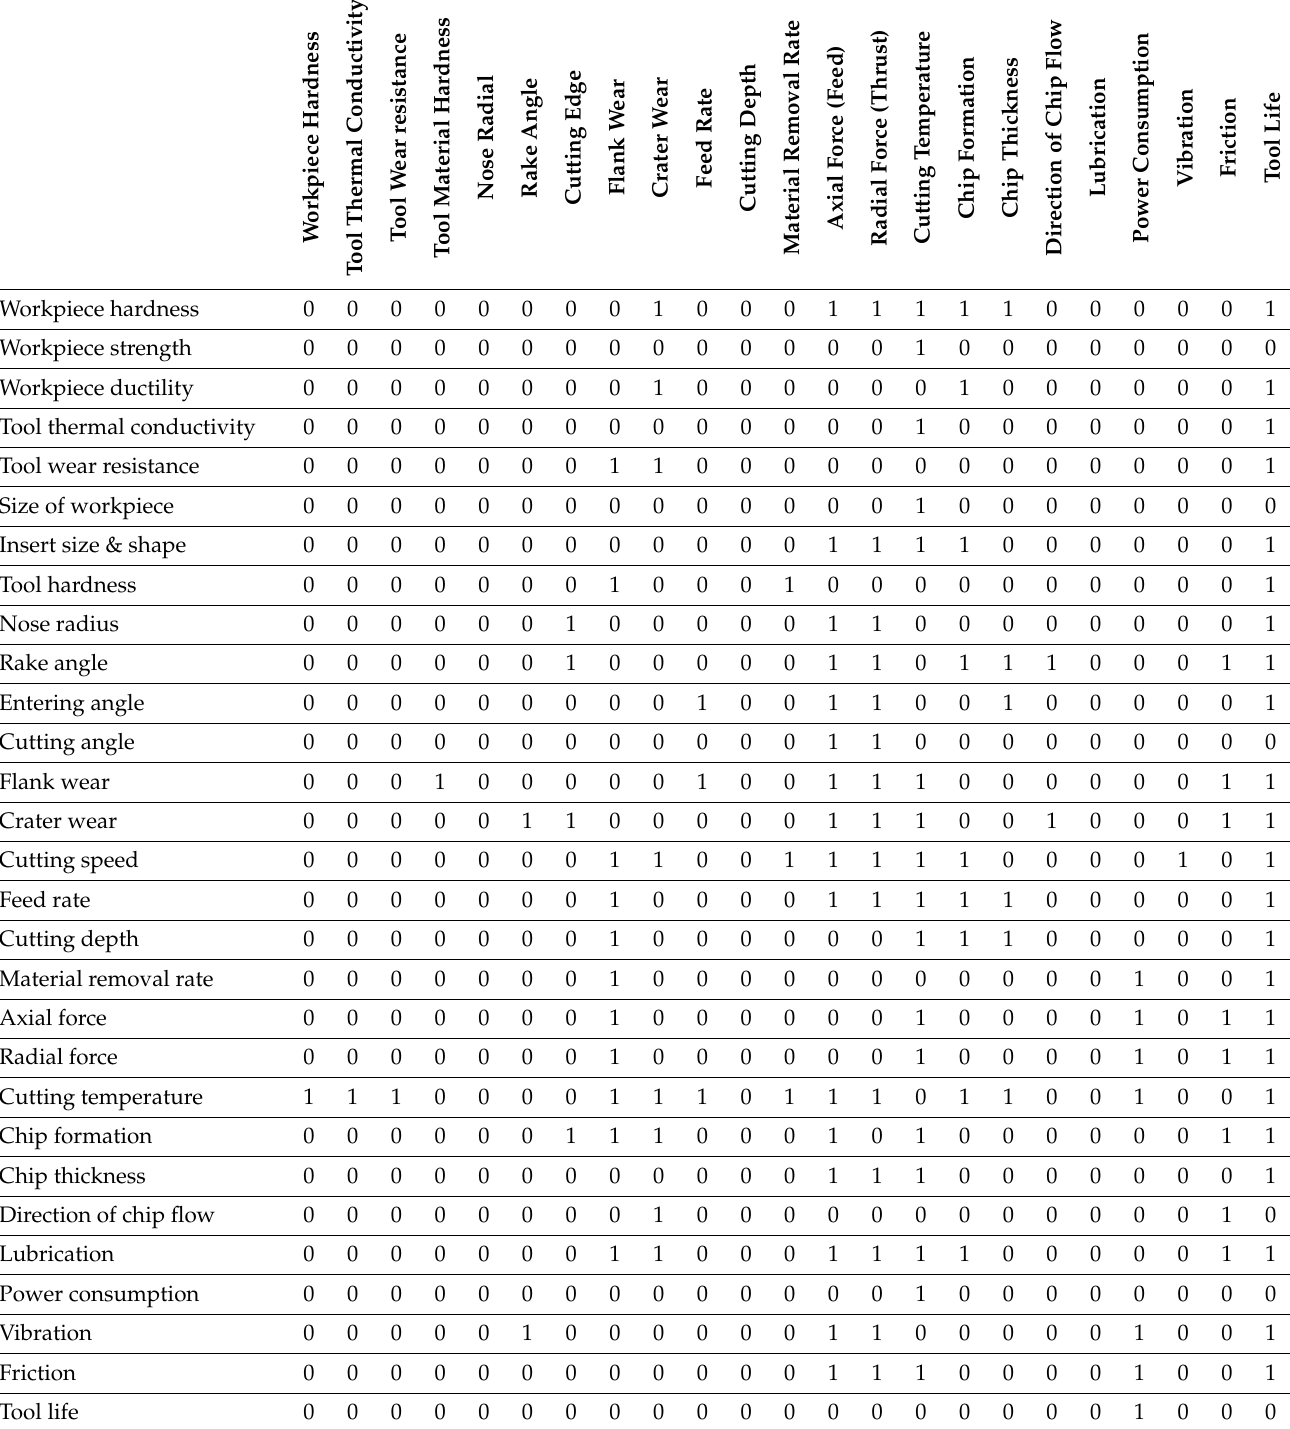
Table 1. Relationship matrix of the parameters affecting tool life in the turning